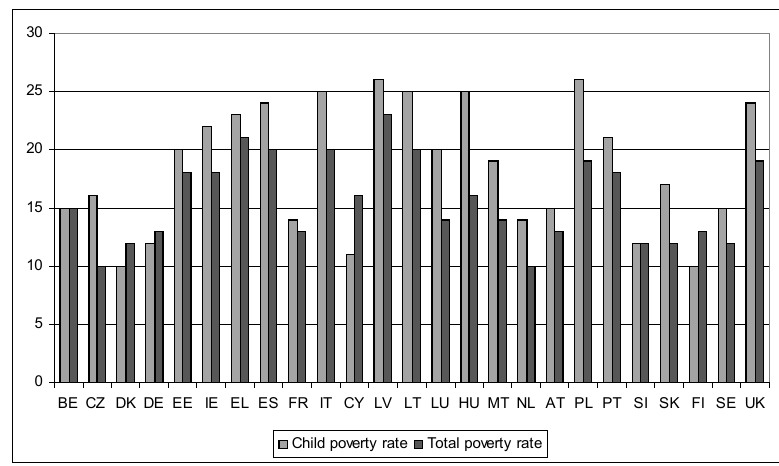
Figure 2 : Child poverty rates by the number of workers